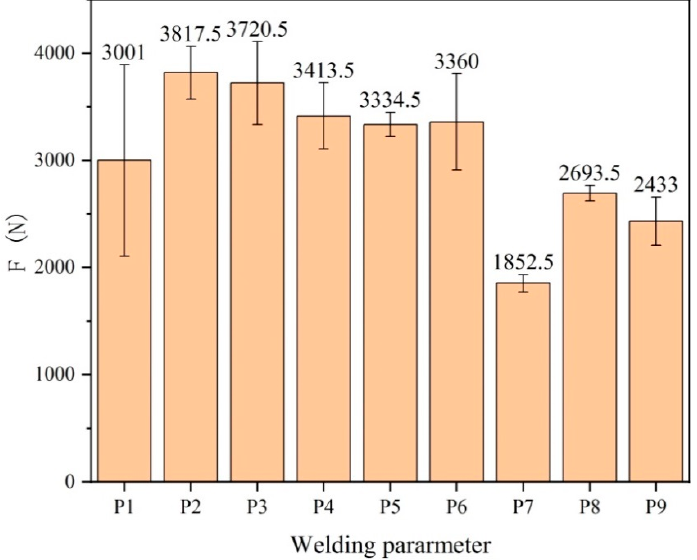
Figure 14. Tensile-shear forces of the